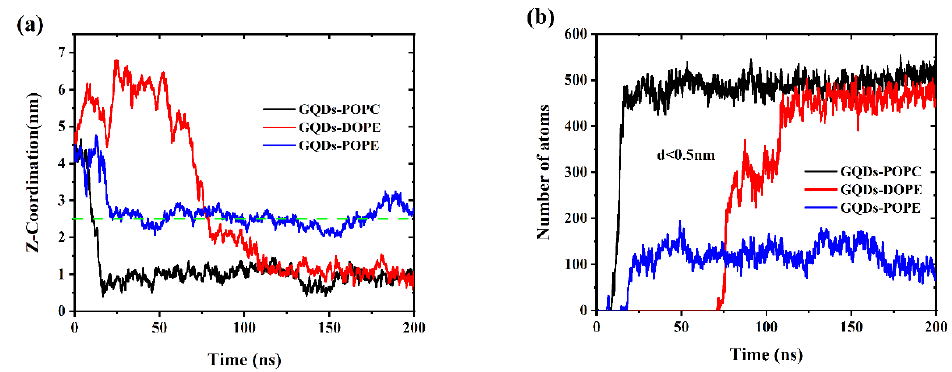
Figure 2. ( a ) Change in distance between the GQDs and the cell membrane in the z-direction. ( b ) Changes in contact numbers between GQDs and cell membrane atoms.